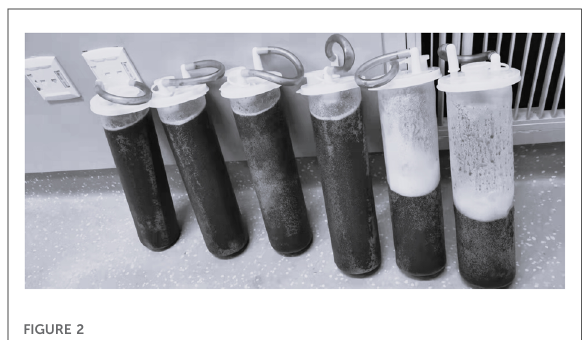
FIGURE 2 The ascitic fl uid of the patient.